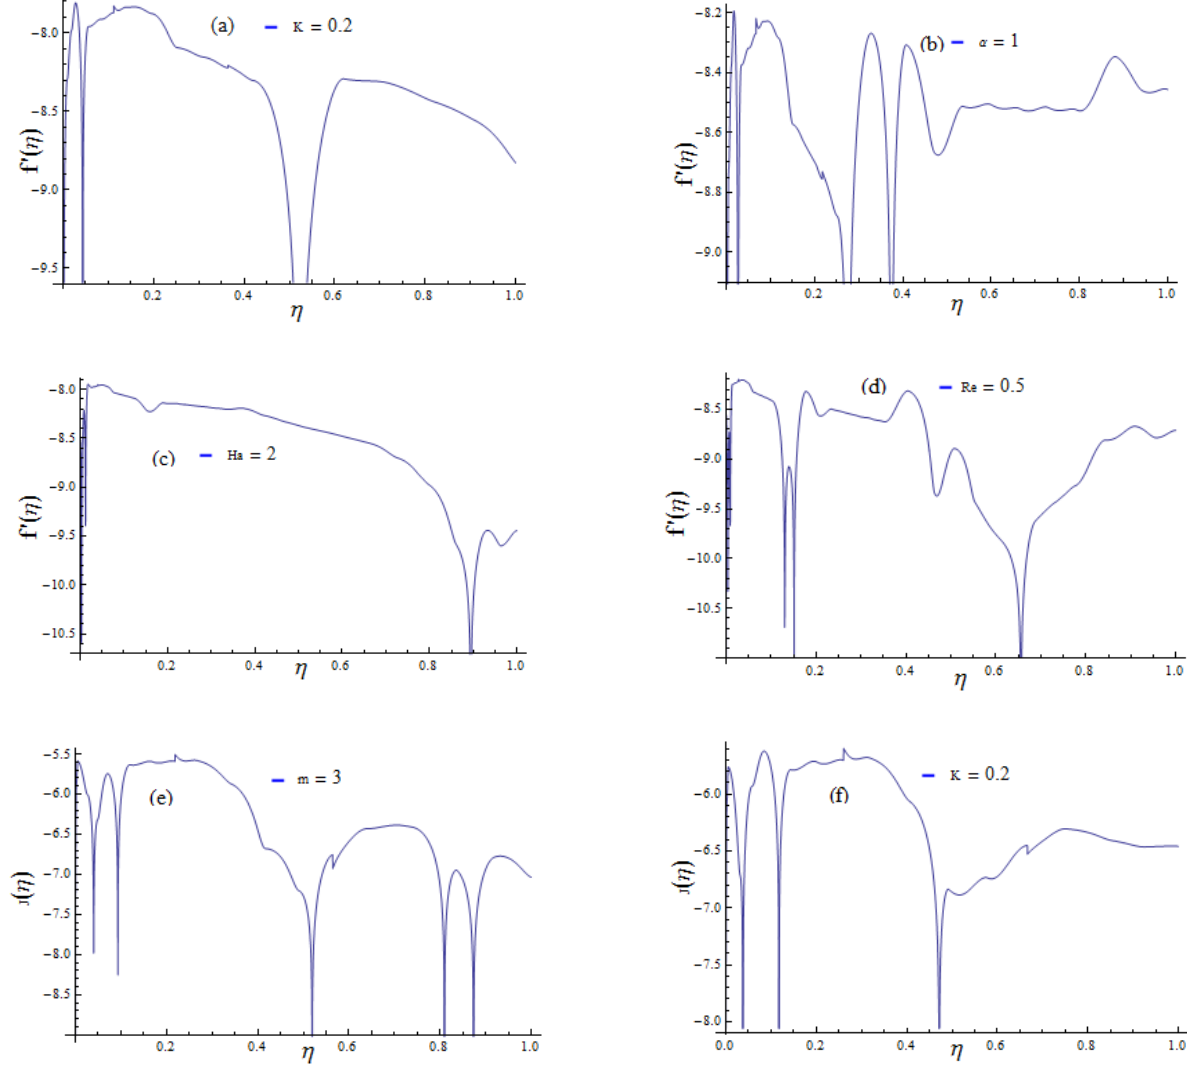
Figure 4. Error analysis for different parameters on velocity profiles ( a ) K on f (cid:48) ( η ) , ( b ) a on f (cid:48) ( η ) , ( c ) Ha on f (cid:48) ( η ) , ( d ) Re on f (cid:48) ( η ) , ( e ) m on J ( η ) , ( f ) K on J ( η ).